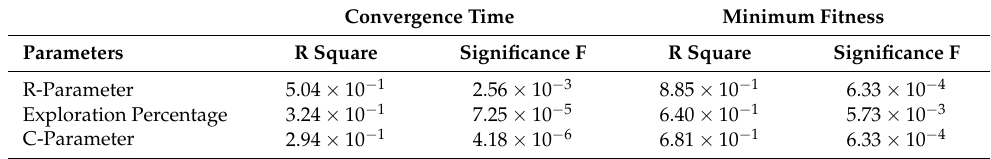
Table 10. Regression analysis results for convergence time and fitness of the DTO algorithm.